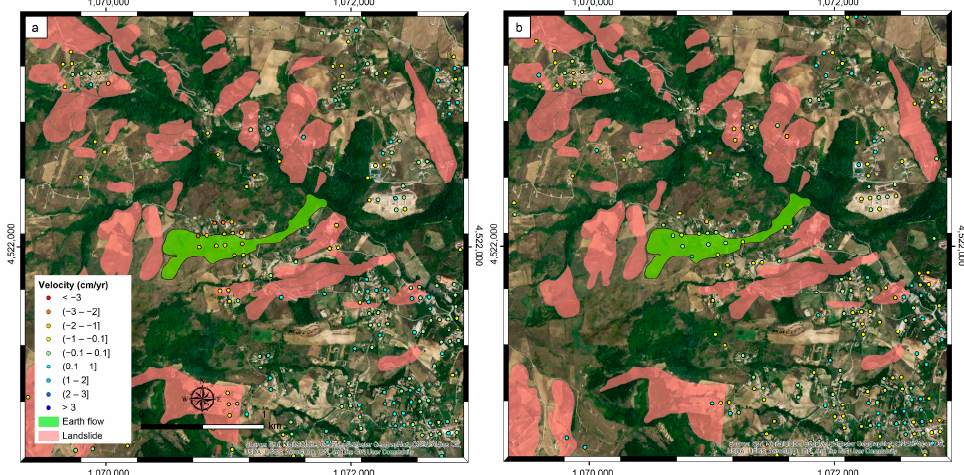
Figure 8. Boundary of the earth flow (landslide 2 in Figure 6), with the points representing the sur ‐ face displacements for the ( a ) T146 ascending orbit (11 pixels) and ( b ) T124 descending orbit (10 pixels), classified according to the average velocity of deformation over the five years of observation (2015–2020). Background from Google Earth.